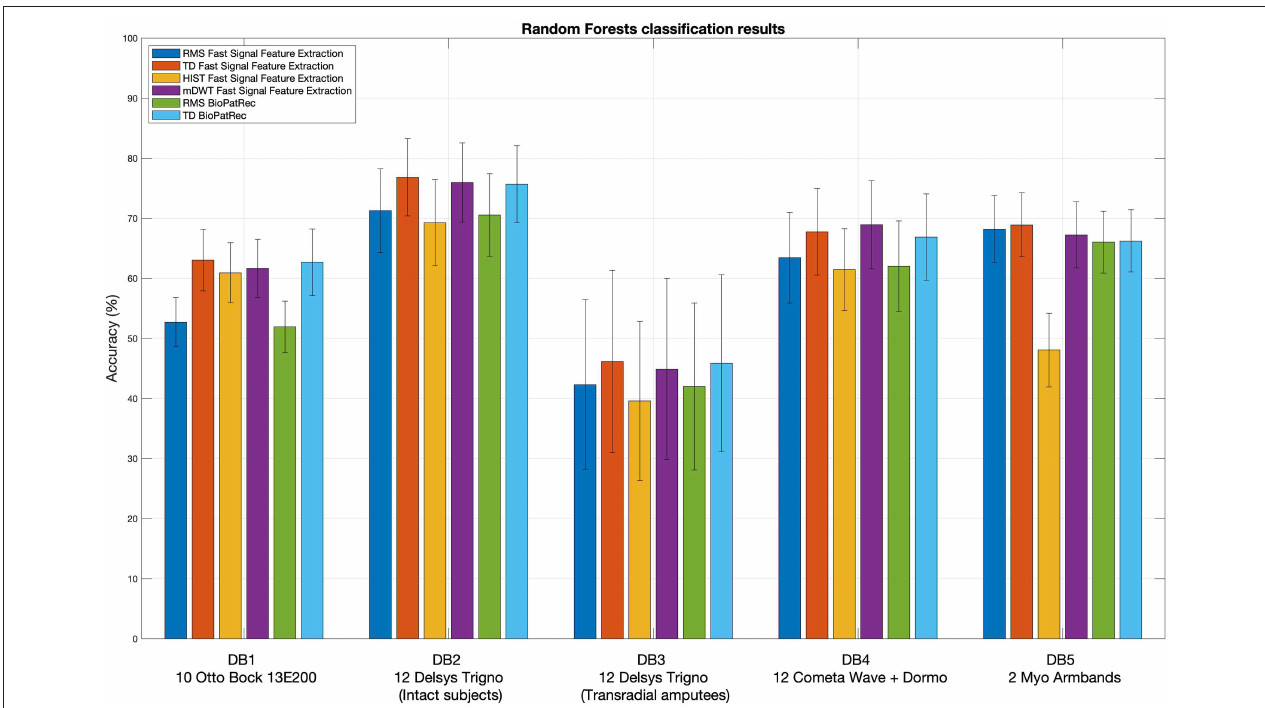
FIGURE 3 | Extracted signal features validation: random Forests classification results obtained using the considered signal features. The histogram includes the classification accuracy obtained for the signal features extracted using BioPatRec as